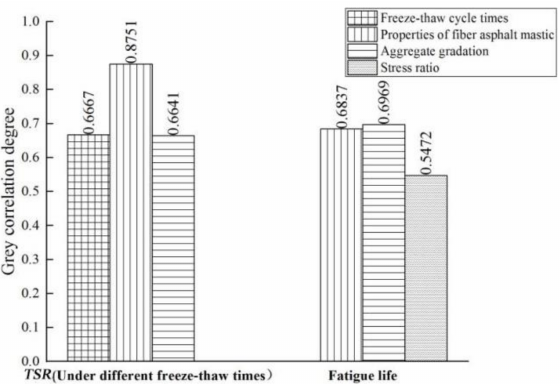
Figure 13. Grey correlation analysis results of influencing factors of freeze-thaw cycle and fa- tigue